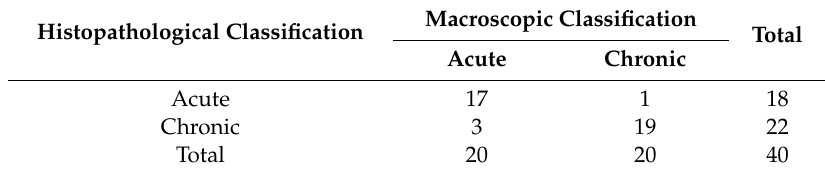
Table 3. Results from histopathology and macroscopic analysis of vertebral osteomyelitis